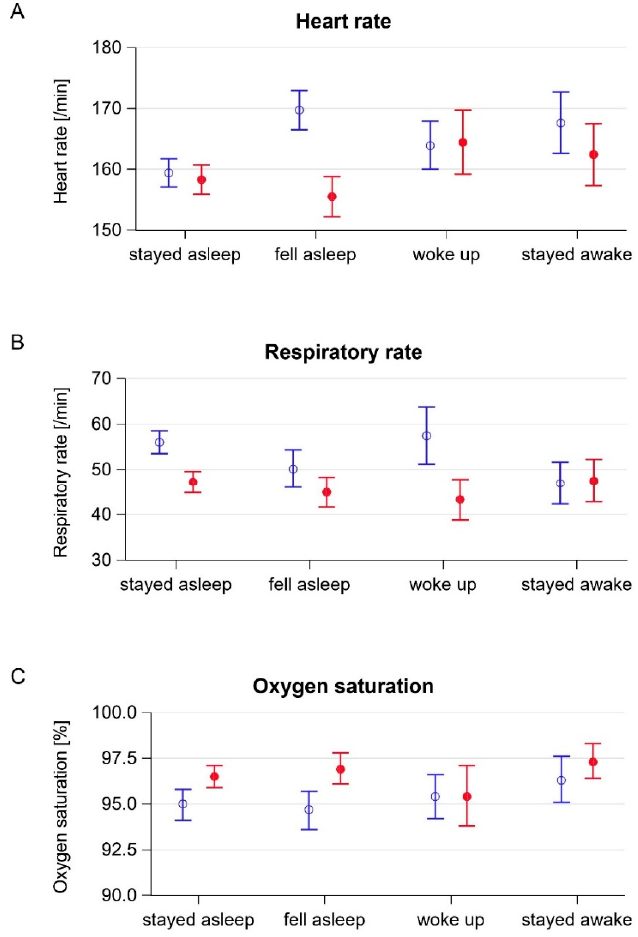
Figure 2. Baseline and post-therapy vital signs by states of wakefulness. Blue empty circle: mean baseline value, red filled circle: mean post-therapy value, blue and red error bars: corresponding 95% confidence intervals. ( A ) Heart rate. ( B ) Respiratory rate. ( C ) Oxygen saturation.